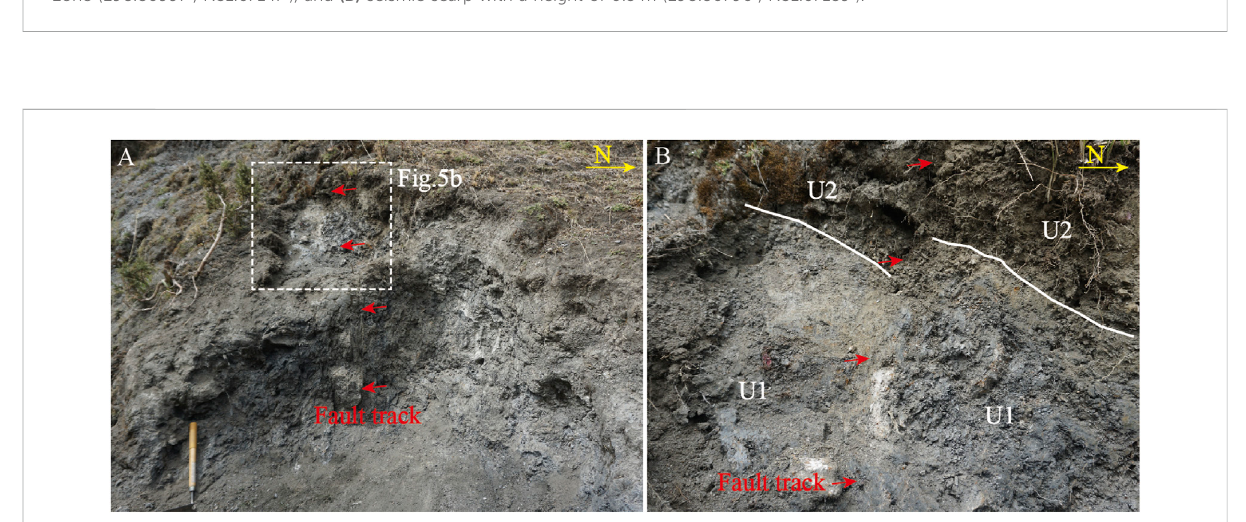
FIGURE 5 Fault outcrop on a hillside along the Baiqu River near Babang (E98.80776 ° , N31.67190 ° ). (A) Photograph showing that the fault has dislocated all of the stratigraphic units in the outcrop pro fi le, and (B) close-up photograph of unit U2, which was dislocated by the